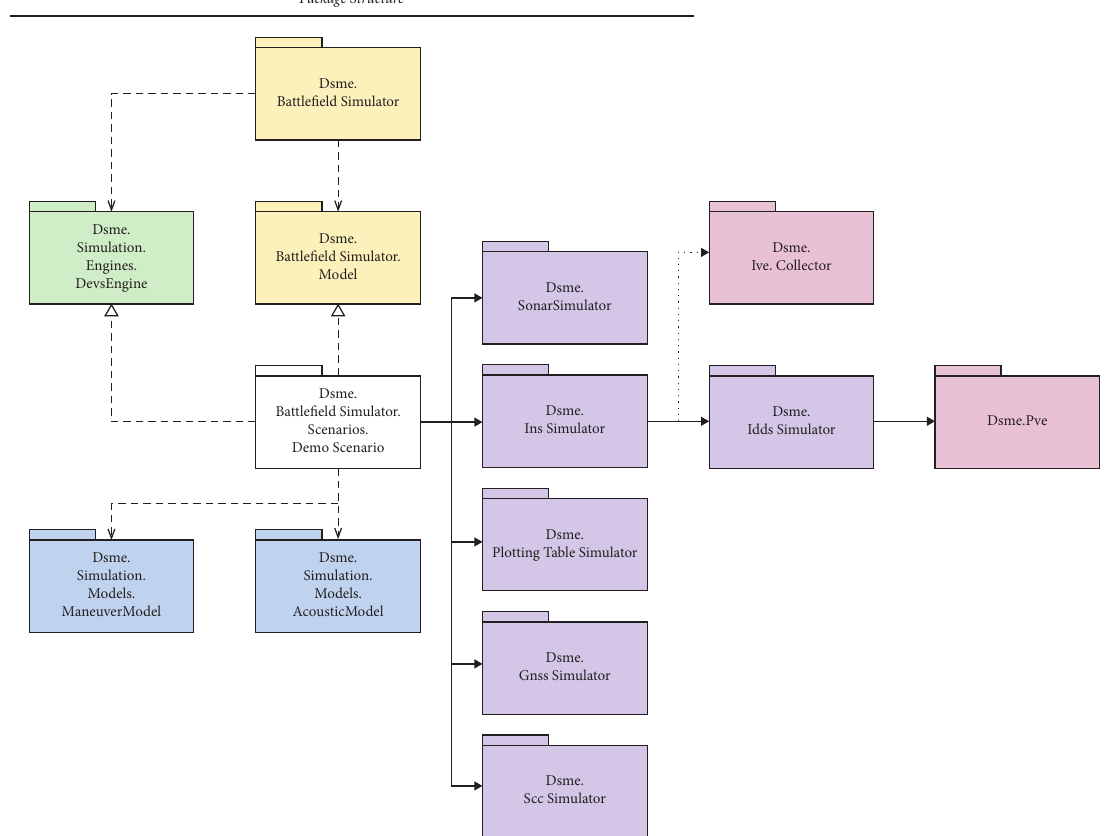
Figure 2: An overall simulation architecture for testing cyber-physical systems.